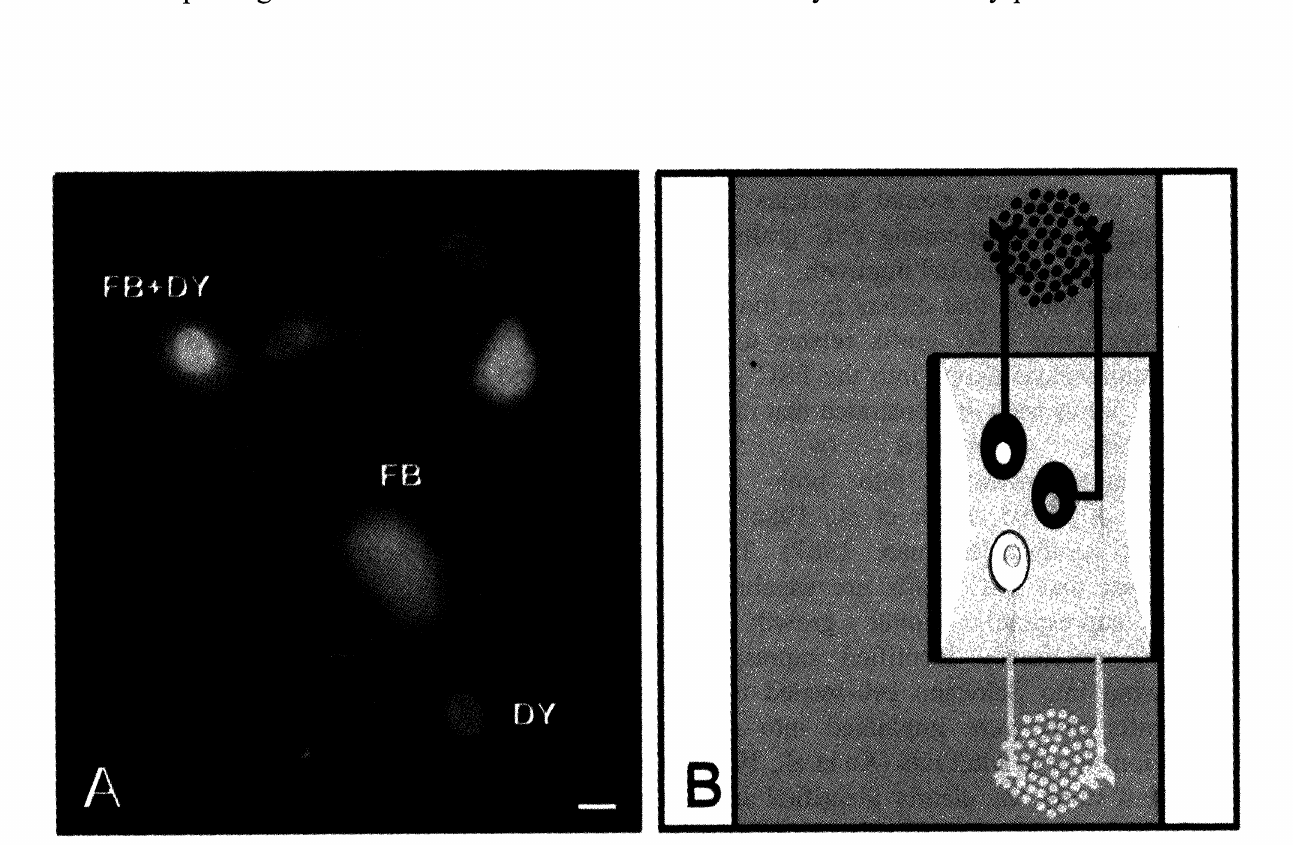
Fig. 9: A: Fluorescence photomicrograph demonstrating that implanted FSC neurons projected axons beyond the host-graft interface and contained Fast Blue (FB), Diamidino Yellow (DY) or both (FB+DY). B: A schematic drawing which represents the three populations of neurons which could be found extending axons beyond the host-graft interface: (1) neurons whose axons extended beyond the rostral interface (blue cell body), (2) neurons whose axons extended beyond the caudal interface (yellow nucleus), and (3) neurons which possess axon collaterals that reach beyond both the rostral and caudal host-graft interfaces (blue cell body and yellow nucleus). Bar: A